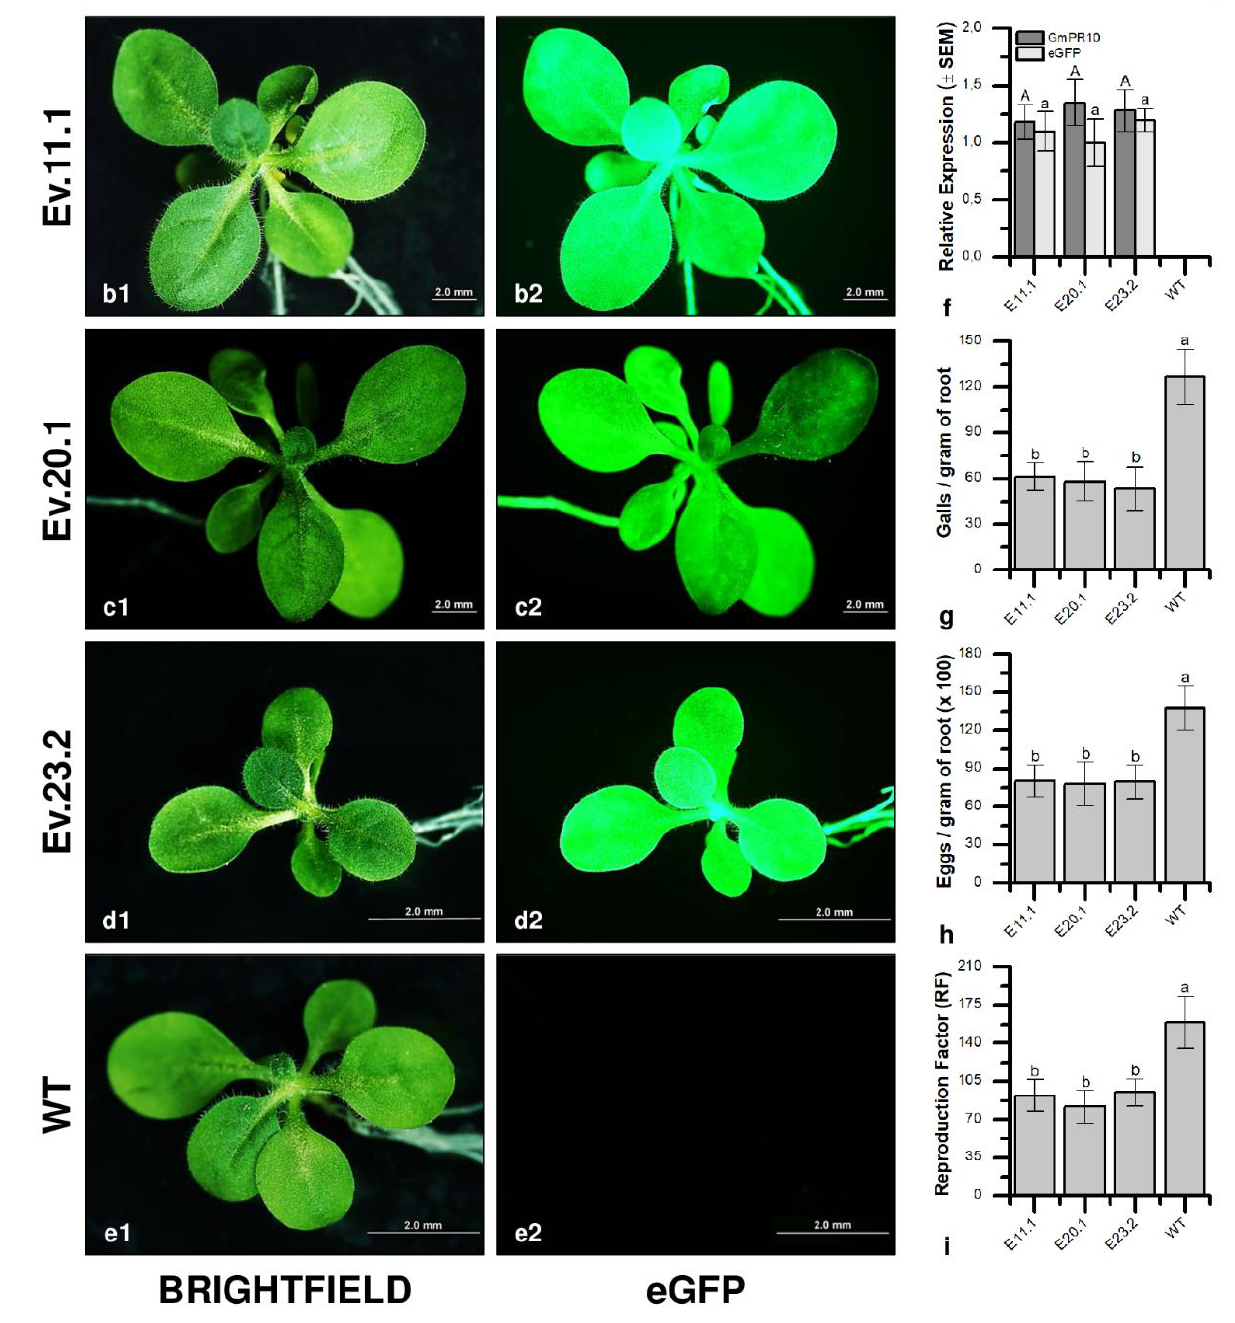
Figure 7. GmPR10 overexpression in transgenic N. tabacum . ( a ) schematic representation of the transformation cassette cloned into the pPZP vector. The GmPR10 and eGFP (a selective marker) genes are both expressed through the CaMV35S promoter. Three independent transformation events were selected based on hygromycin resistance and eGFP fluorescence at 488 nm. ( b1 – e1 ) bright- field images of Ev11.1, Ev20.1, Ev23.2, and non-transformed wild-type (WT) tobacco plants and ( b2 – e1 ) images of eGFP fluorescence in the same plants. The GmPR10 and eGFP overexpression was evaluated by RT–qPCR as observed in ( f ). At 60 days after inoculation (DAI), the following parameters were analyzed in soybean- M. incognita bioassays: ( g ) galls per gram of root; ( h ) eggs per gram of root; and ( i ) M. incognita reproduction factor. The letters A/a/b presented in ( f – i ) correspond to groups of ANOVA statistical